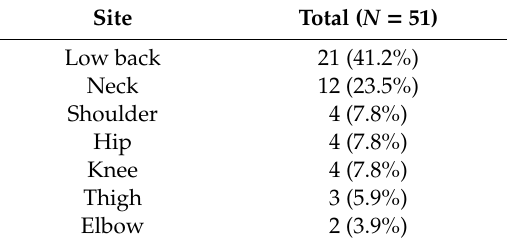
Table 3. Sites of home working-related pain *.